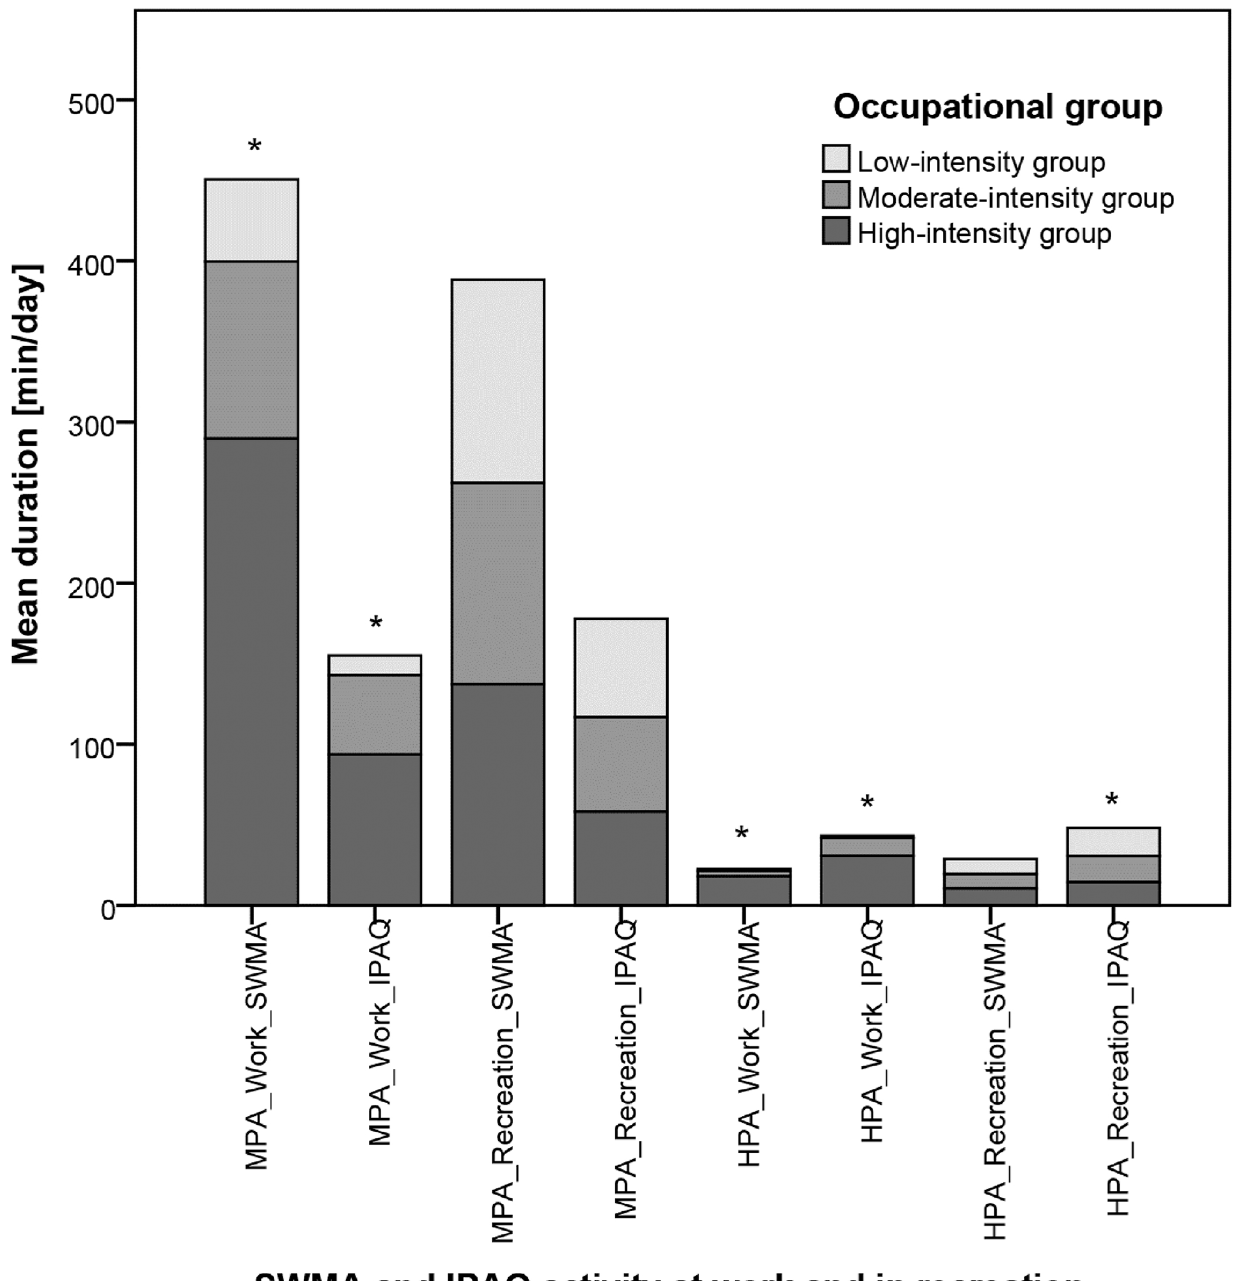
Fig 2. Comparison of objective SWMA activity data with subjective IPAQ activity data. HPA_Recreation_IPAQ / HPA_Work_IPAQ, physical activity duration at high intensity (8 METs) based on the International Physical Activity Questionnaire; HPA_Recreation_SWMA / HPA_Work_SWMA, physical activity duration at high intensity (6 – 9 METs) measured by the SenseWear Mini armband; MPA_Recreation_IPAQ / MPA_Work_IPAQ, physical activity duration at moderate intensity (3 – 6 METs) based on the International Physical Activity Questionnaire; MPA_Recreation_SWMA / MPA_Work_SWMA, physical activity duration at moderate intensity (3 – 6 METs) measured by the SenseWear Mini armband. * Intergroup comparisons (low-intensity vs. moderate-intensity vs. high-intensity group) revealed highly significant differences (p <